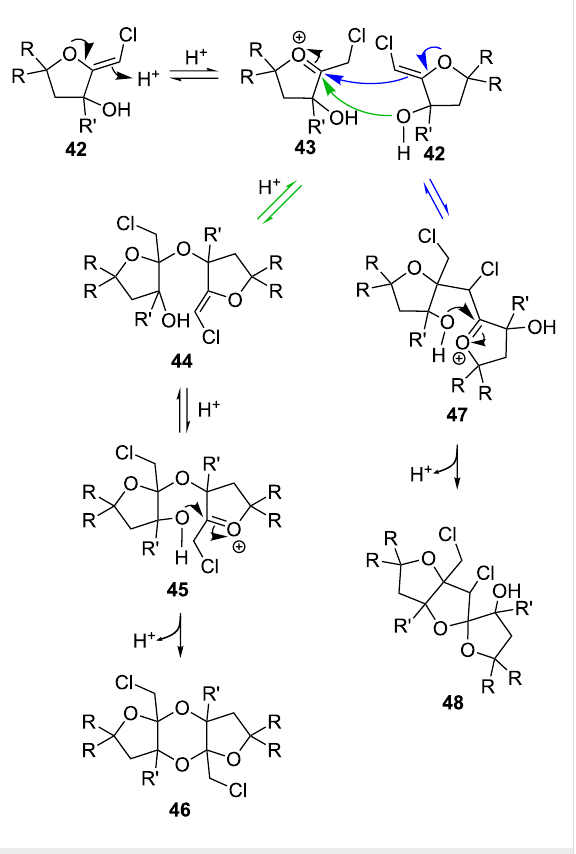
Scheme 8: Mechanism leading to dioxanes and